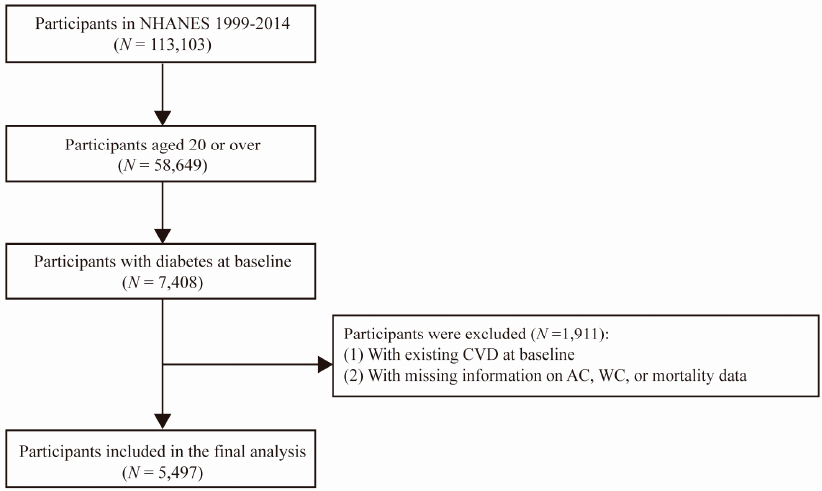
Figure 1. Flowchart of participants with diabetes included in the analysis.